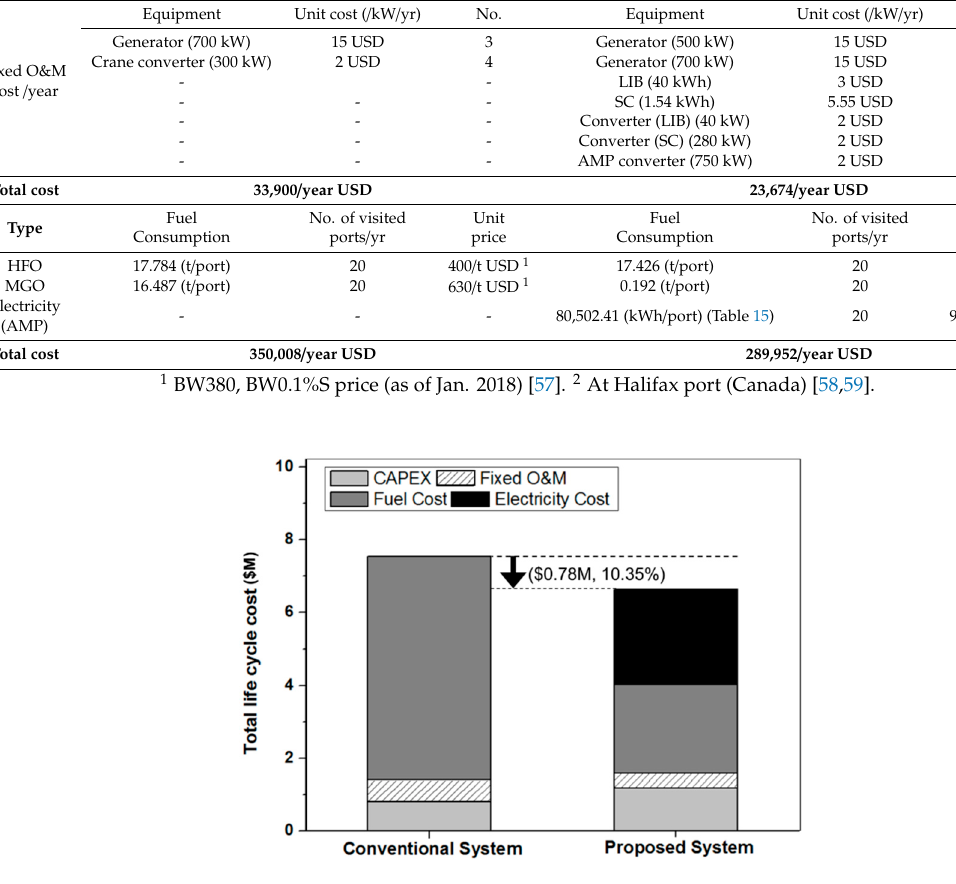
Figure 13. Total life cycle costs for conventional and proposed systems based on present values (25 years; i = 5%; a, b, c = 2%; electricity cost = 9.2 cents/kWh).